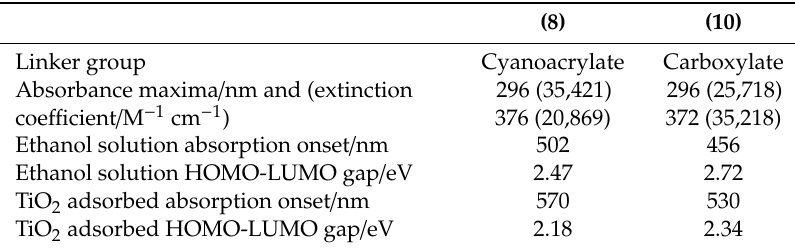
Table 1. Spectral data for solution and TiO 2 adsorbed dyes.